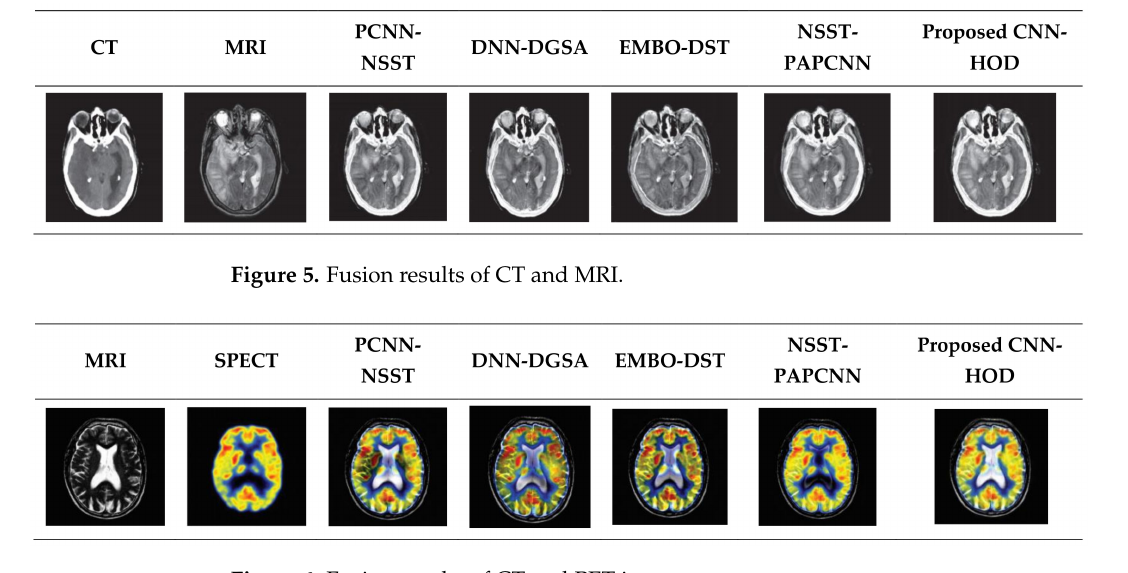
Figure 6. Fusion results of CT and PET images.